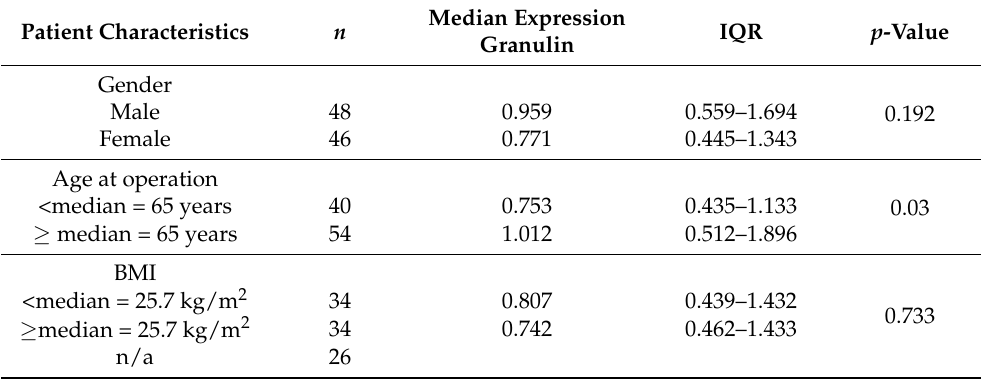
Table 1. Overview of clinical characteristics and expression of granulin; n/a = not